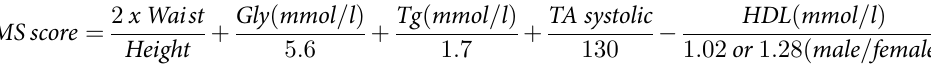
(waist—waist circumference in cm, Gly—glucose, Tg—triglycerides, TA systolic—systolic arterial blood pressure, HDL—HDL